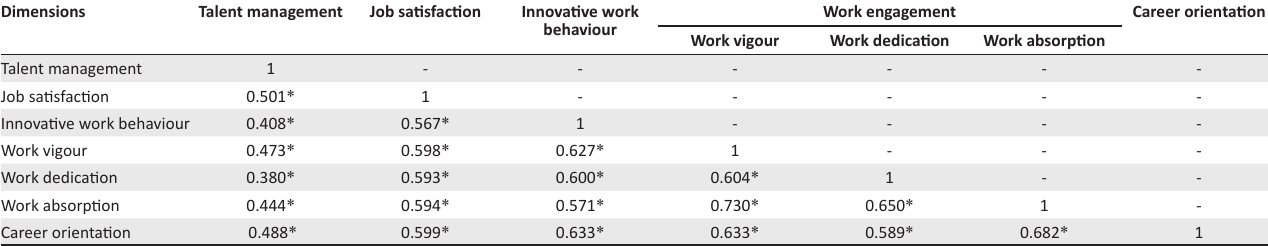
TABLE 2: Correlation between dimensions of work engagement, talent management, innovative work behaviour, job satisfaction and career orientation.